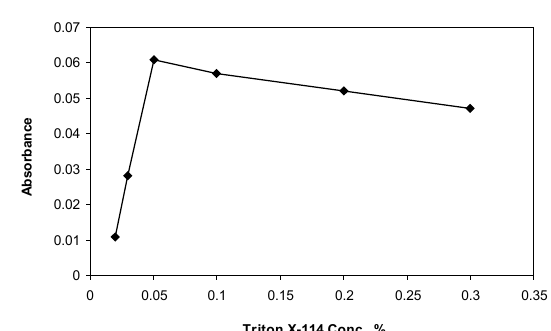
Figure. 3. Variation of the analytical signal of the gold as a function of Triton X-114 concentration Conditions: 100 ng mL -1 Au, 5×10 -6 mol L -1 brilliant green, 0.1 M hydrochloric acid.